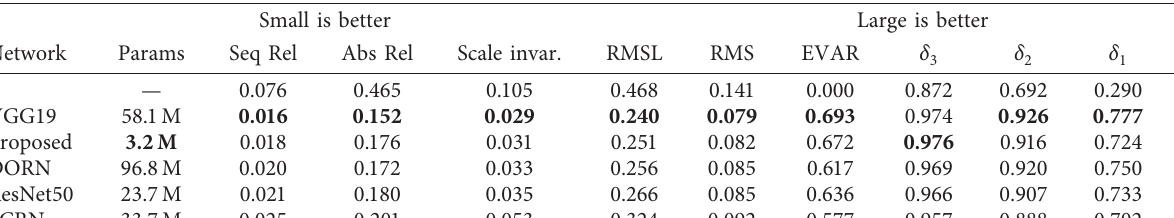
Figure 3: The region of targets inside the image in the KITTI dataset. The higher arc is at 4 meters, while the lower one is at 60 meters. There are 80 laser points per line. Table 1: Results on KITTI test dataset.